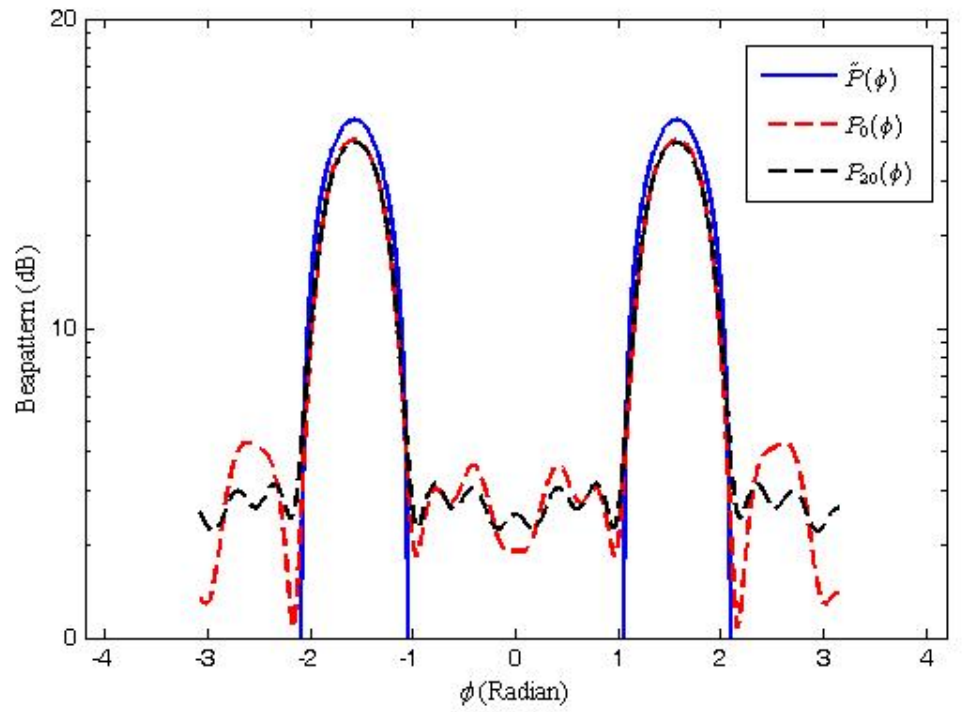
Figure 5. The desired beampattern vs. the transmit beampattern obtained by using the cosine method 20 times ( M =